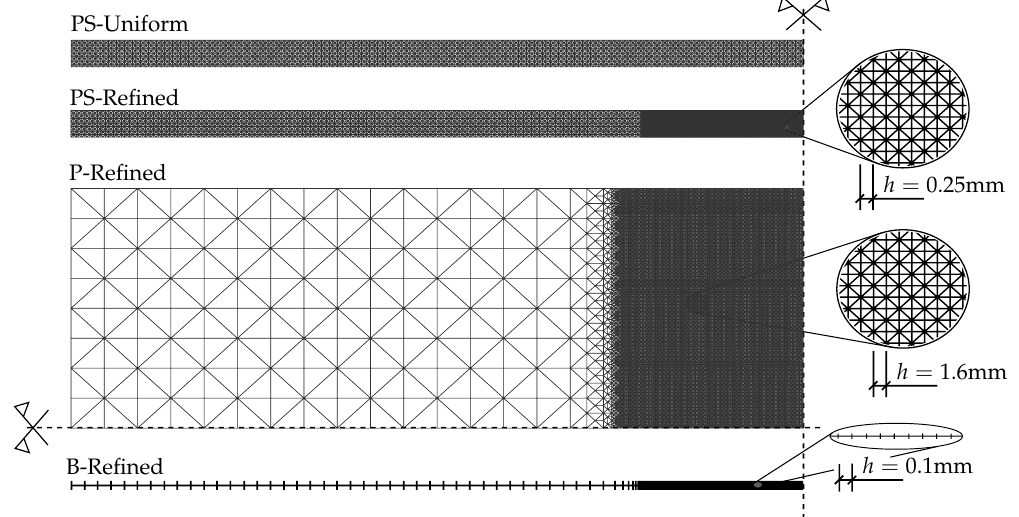
Figure 4. Regular uniform or refined discretization for the 2D plane-stress model (PS) and refined meshes used for a quarter of a plate (P) and a half of a beam